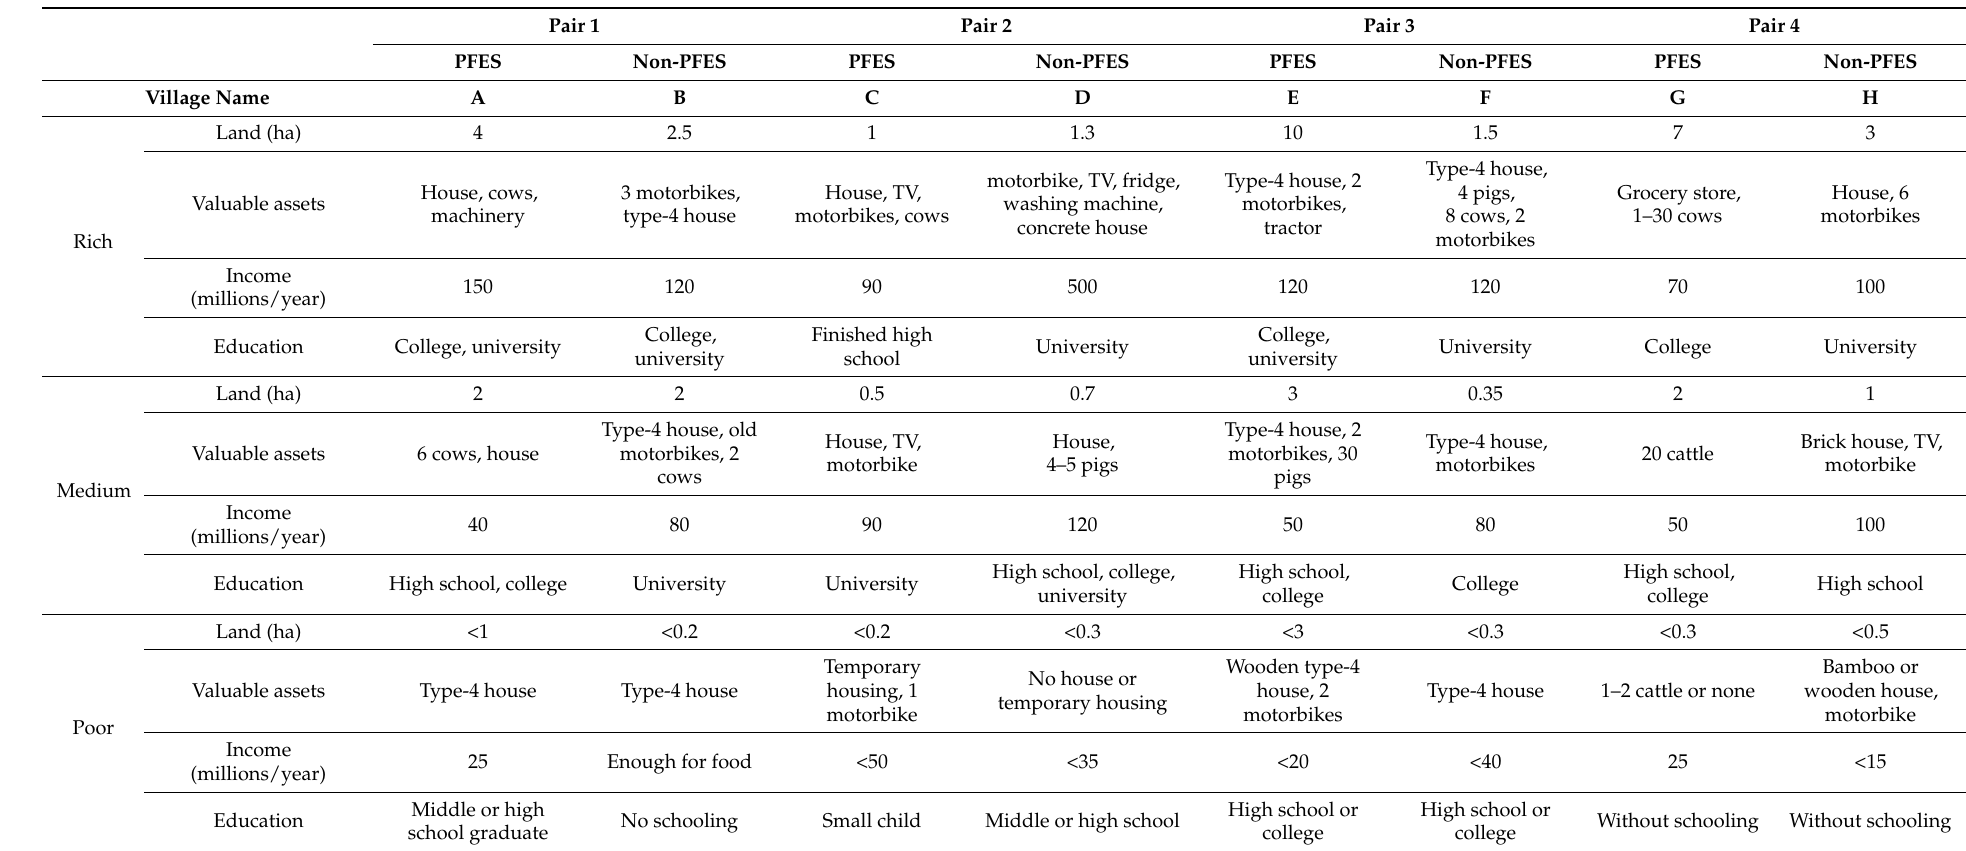
Table 5. Local definitions of poor, middle and rich